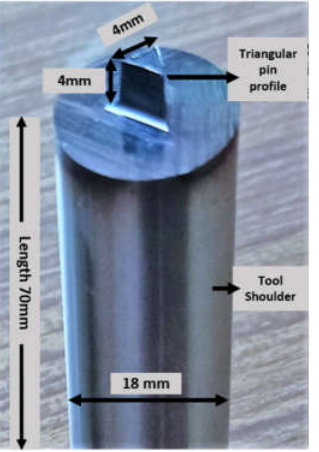
Figure 3. Photographic view of the HSS tool used in the experiment.